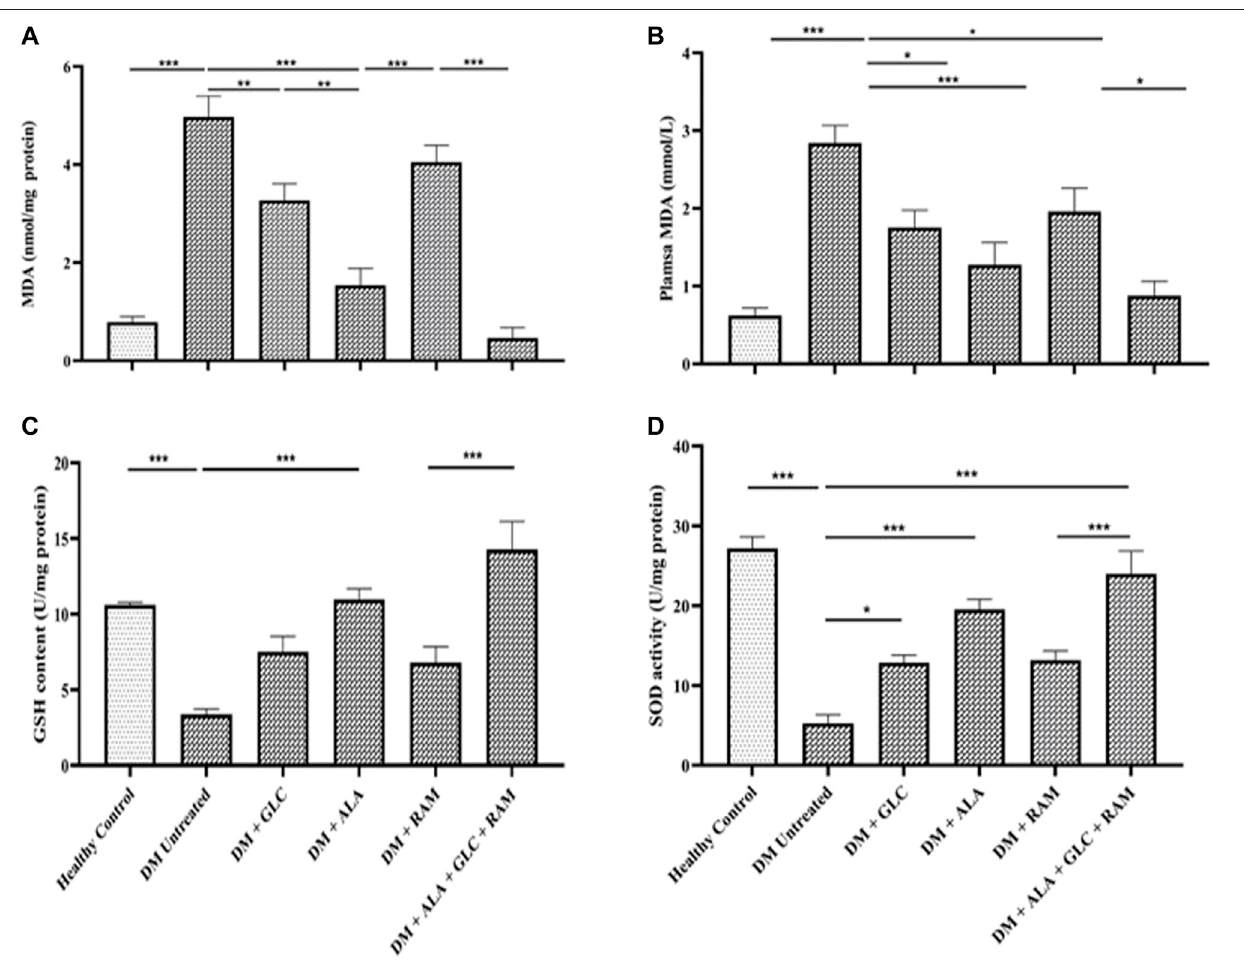
FIGURE4| Cardiacantioxidantstatus.Levelsof (A) cardiactissuemalondialdehyde(MDA), (B) plasmamalondialdehyde(MDA), (C) cardiacglutathione(GSH)content and (D) cardiacsuperoxidedismutase (SOD)activity. Healthy control( n = 7); DM Untreated = Untreateddiabetesmellitusrats( n = 9);DM+ GLC= Diabeticratstreated with gliclazide( n =7);DM+ALA=Diabeticratstreatedwithalpha-lipoicacid( n =7);DM+RAM=Diabeticratstreatedwithramipril( n =7);DM+ALA+GLC+RAM=Diabeticrats treated with alpha-lipoic acid, gliclazide and ramipril ( n = 7). * p < 0.05 vs. diabetic control, ** p < 0.01 vs. diabetic control, *** p < 0.001 vs. diabetic control.